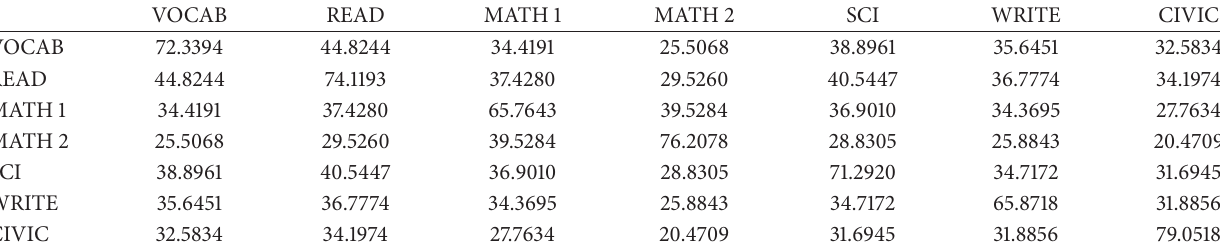
Table 7: Posterior mean for Σ with an informative